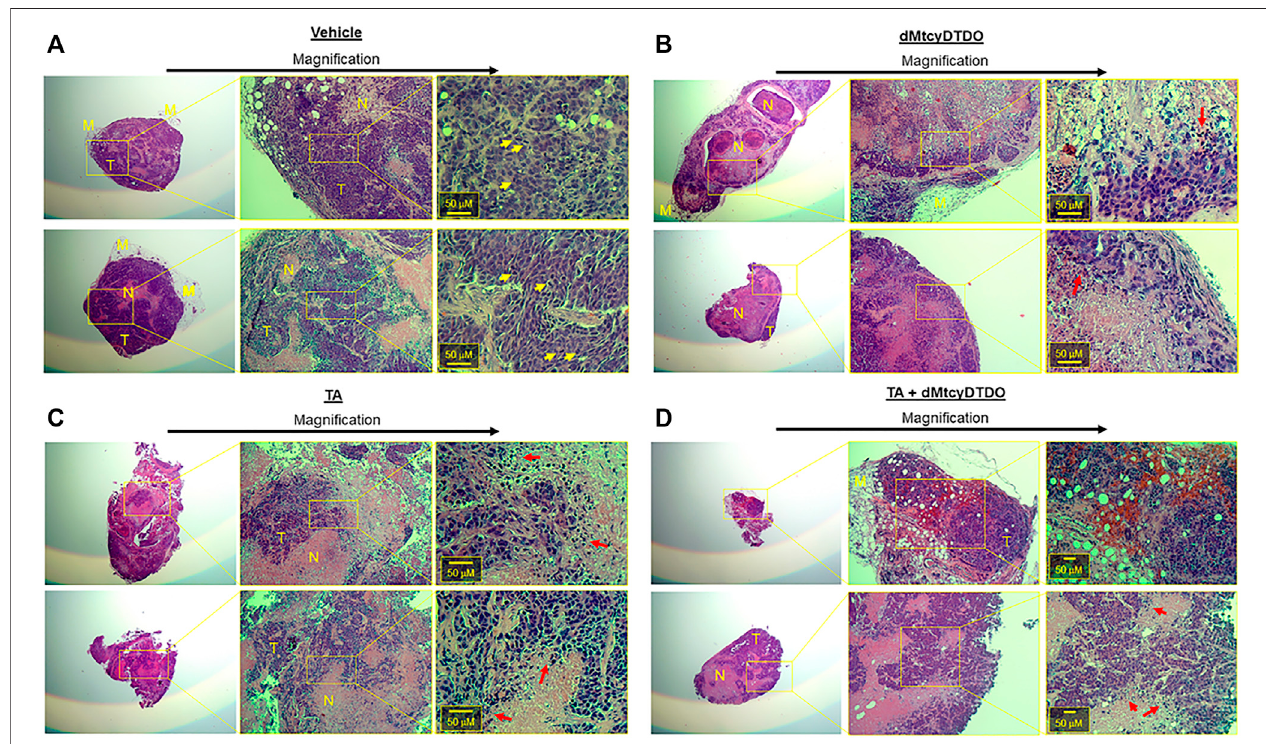
FIGURE 5 | TA and dMtcyDTDO cause tumor cell death in animal models. At endpoint, two tumors from the (A) Vehicle, (B) dMtcyDTDO, (C) TA, and (D) TA + dMtcyDTDO treatment groups were paraf fi n-embedded, sectioned and stained with hematoxylin and eosin (H&E). Each section is shown at three different magni fi cations with scale bars on the highest magni fi cation images. T refers to viable tumor tissue, N, necrotic/dead tissue, and M, mammary tissue. Yellow arrows denote cells undergoing mitosis and red arrows indicate cells undergoing nuclear condensation and fragmentation, indicative of cell